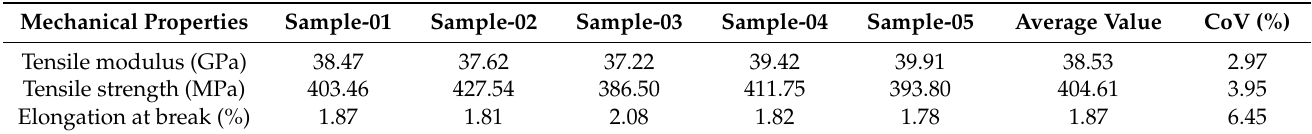
Table 2. Mechanical properties generated from Step 1.